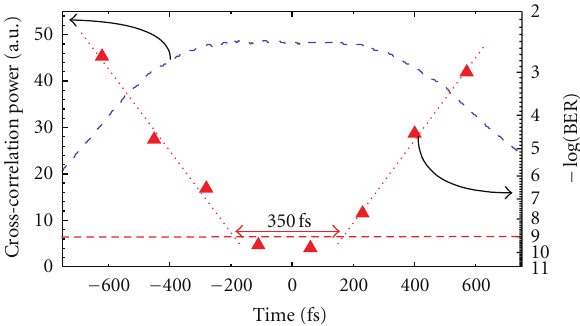
Figure 14: BER timing-jitter tolerance (triangles) and intensity profile of the used flat-top pulse